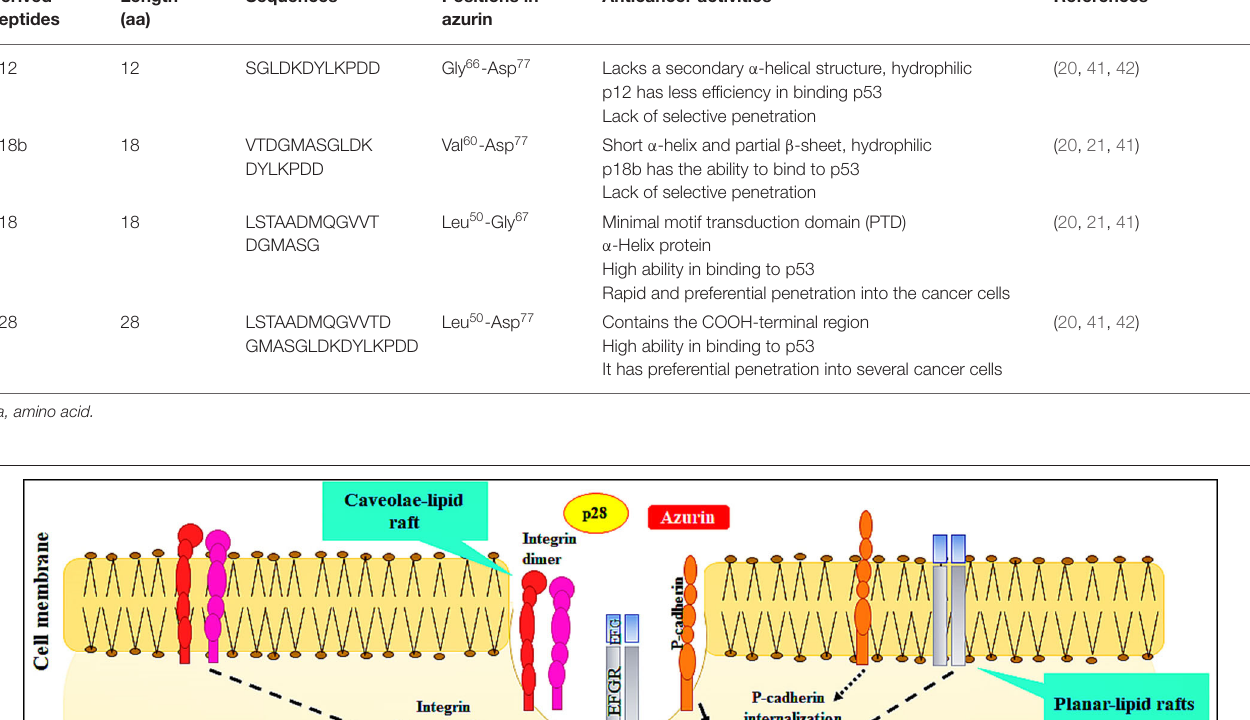
TABLE 1 | Characteristics of azurin-derived peptides. Derived peptides